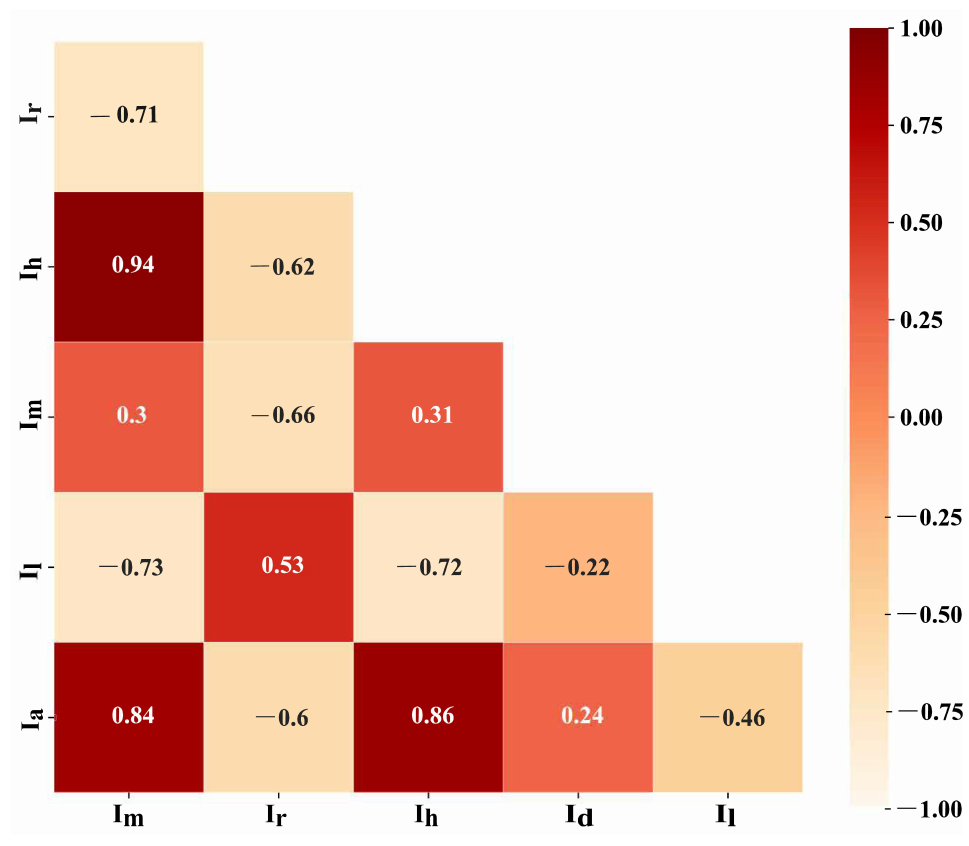
Figure 2. The Pearson correlation coefficients.